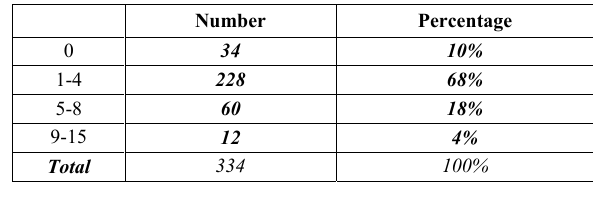
TABLE II. VISIR ACCESSES SORTED BY INTERVALS